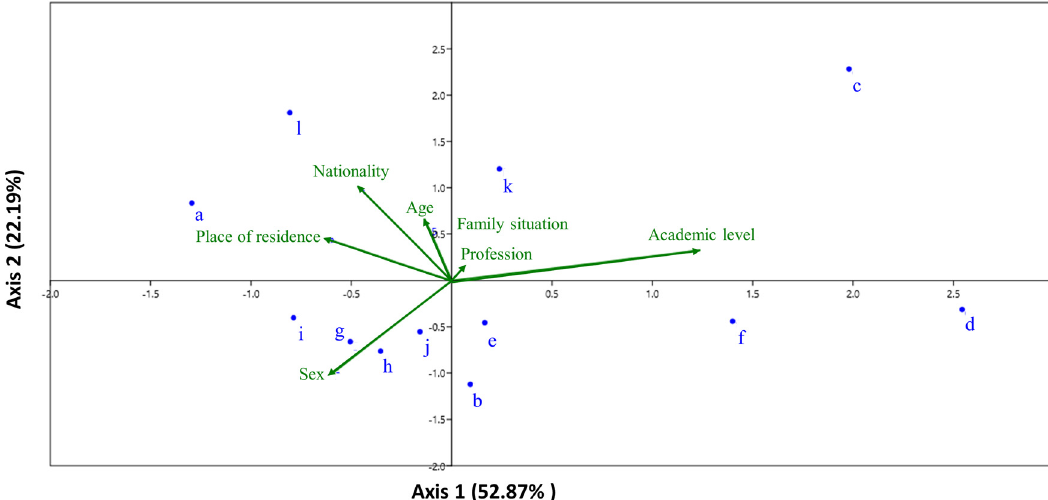
Figure 3: CCA representing the reasons that encourage/discourage the consumption of organic products. ( a ) Do you consume organic products? ( b ) What are the criteria that hold back your organic purchases? [ The unavailability in your entourage or the di ffi culty to fi nd these organic products ] . ( c ) What are the criteria that slow down your organic purchases? [ The organic product is indi ff erent compared to other products ] . ( d ) What are the criteria that slow down your organic purchases? [ Lack of knowledge of organic products in general ] . ( e ) What are the criteria that slow down your organic purchases? [ The price ] . ( f ) What are the criteria that hold back your organic purchases? [ Taste ] . ( g ) What are the criteria that hold back your organic purchases? [ The taste ] . ( h ) For what reason ( s ) or criterion ( s ) do you consume or prefer organic products? [ Because organic products are good for my health ] . ( i ) For what reason ( s ) or criterion ( s ) do you consume or prefer organic products? [ Because organic products have a good quality ] . ( j ) For what reason ( s ) or criterion ( s ) do you consume or prefer organic products? [ For the respect of the environment ] . ( k ) For what reason ( s ) or criterion ( s ) do you consume or prefer organic products? [ For product traceability and tracking ] . ( l ) For what reason ( s ) or criterion ( s ) do you consume or prefer organic products? [ Because the price re fl ects the quality of the product ] . ( m ) For what reason ( s ) or criterion ( s ) do you consume or prefer organic products? [ Because conventional products contain pesticide residue ( s )]